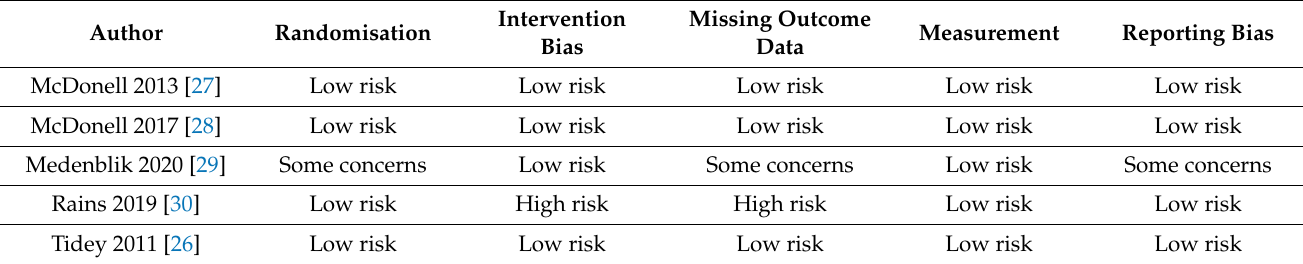
Table 1. The level of risk of bias by the revised risk-of-bias tool